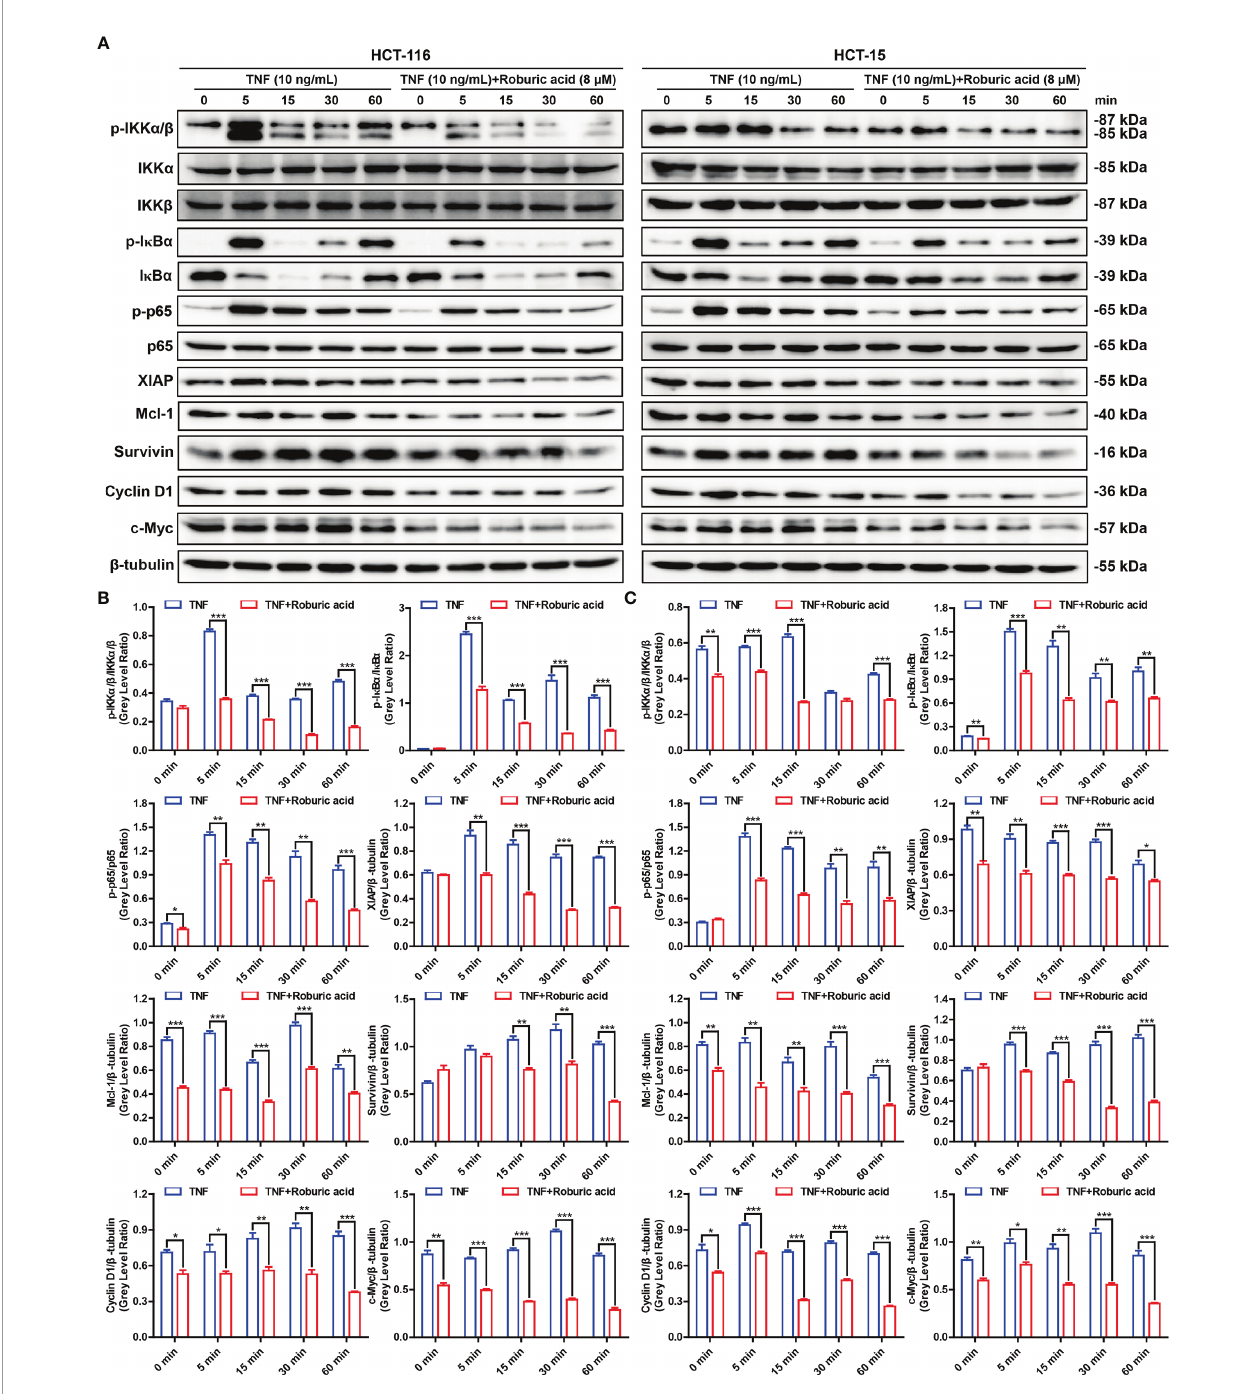
FIGURE 5 | Roburic acid inhibits the TNF-induced NF- k B signaling pathway and antiapoptotic protein expression in colorectal cancer cells. (A) HCT-116 and HCT- 15 cells were cultured in serum-free medium for 12 h and then pretreated with or without roburic acid (8 m M) for 4 h, followed by stimulation with TNF (10 ng/mL) for the indicated times. The cell lysates were used for immunoblotting analysis to measure the expression levels of the indicated proteins. Beta-tubulin was used as the loading control. The gray densities of the bands corresponding to the indicated proteins in HCT-116 (B) and HCT-15 (C) cells were quanti fi ed using AlphaView software. Representative images are displayed. Data are shown as means ± SEM of three independent replicates. Asterisks indicate signi fi cant differences compared with the TNF treatment at the same time point (* P < 0.05, ** P < 0.01, and *** P <